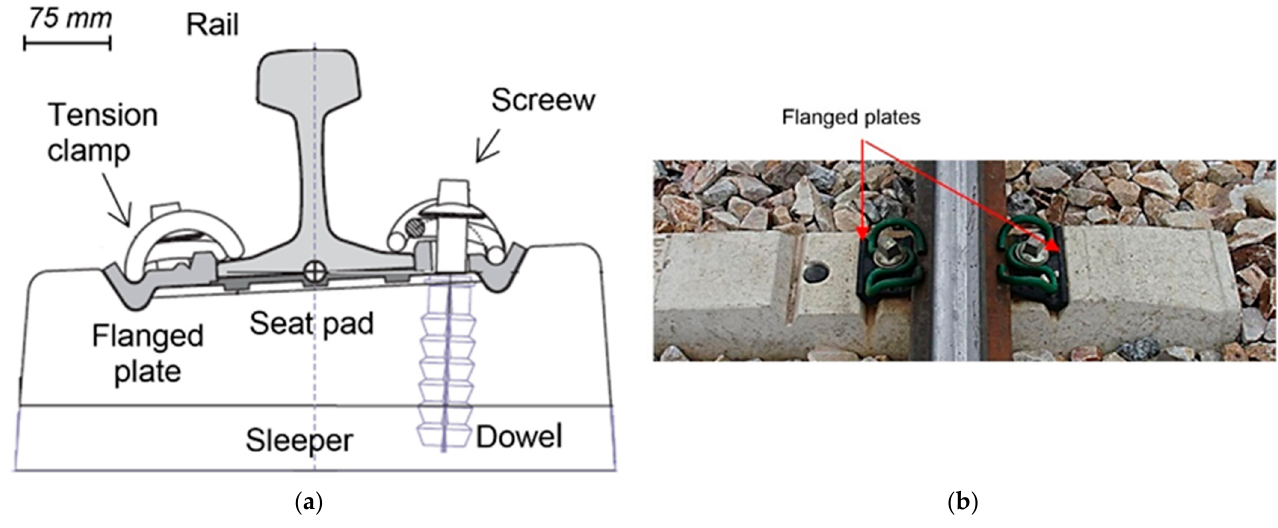
Figure 1. High-speed railway fastening system (VM). ( a ) Scheme of the fastening system. ( b ) Real picture of the fastening system.